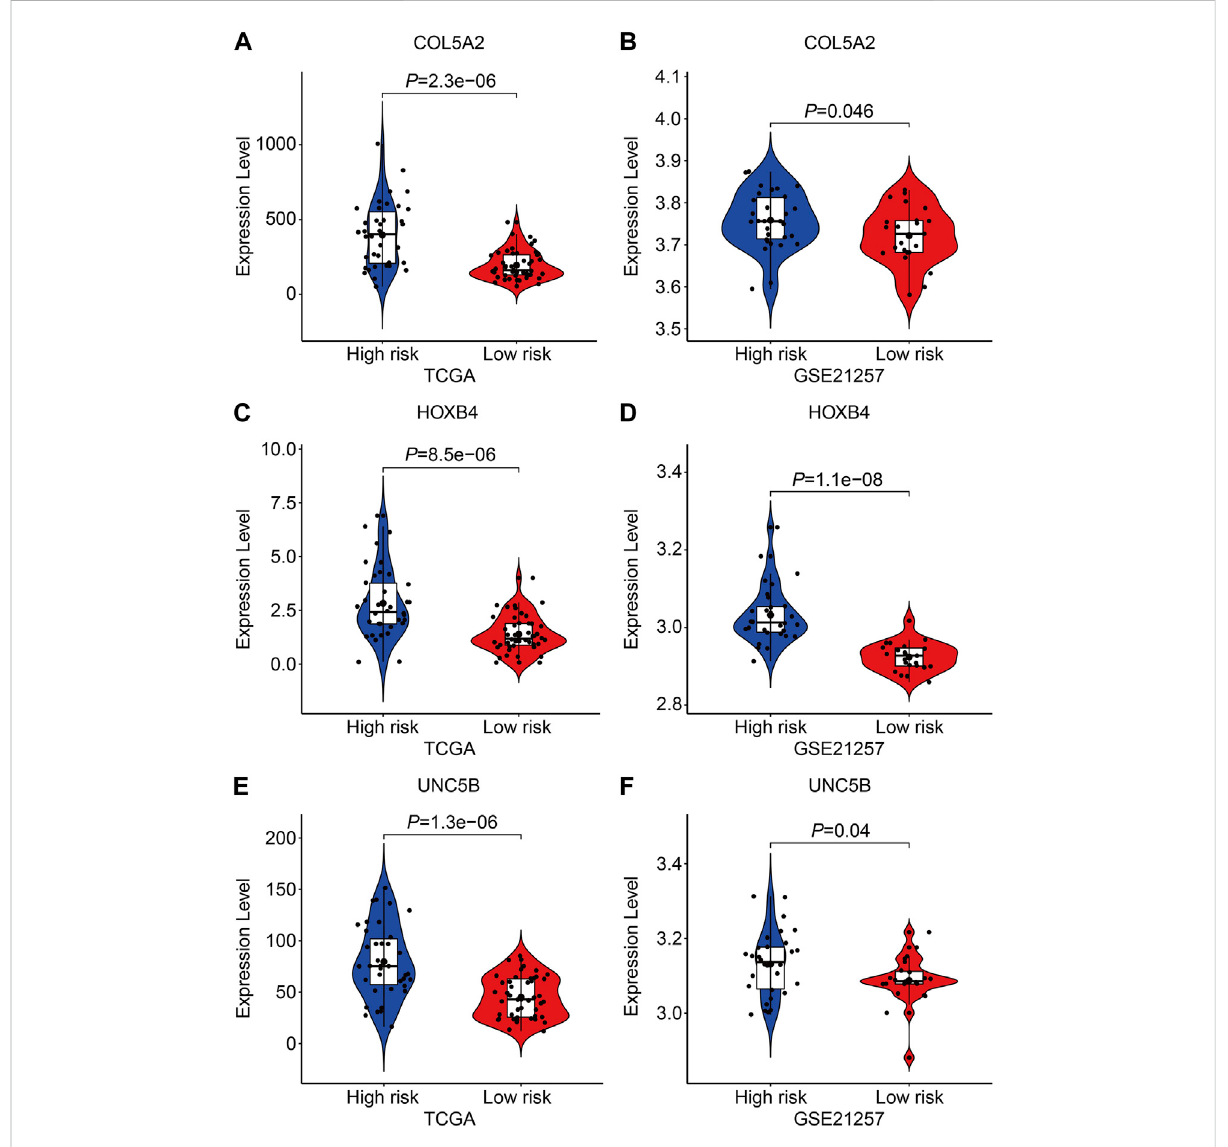
FIGURE 10 Comparison of the expression of COL5A2 (A,B) , HOXB4 (C,D) , and UNC5B (E,F) in different risk groups in TCGA and GSE21257